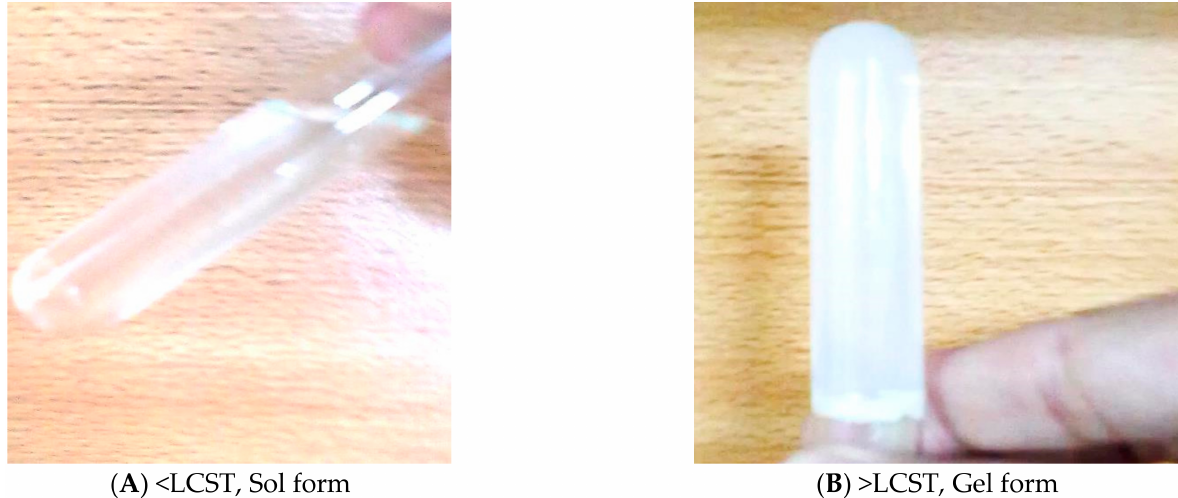
Figure 6. Sol-gel state transition of chemically grafted Poly (NVCL-g-NaAlg) depot